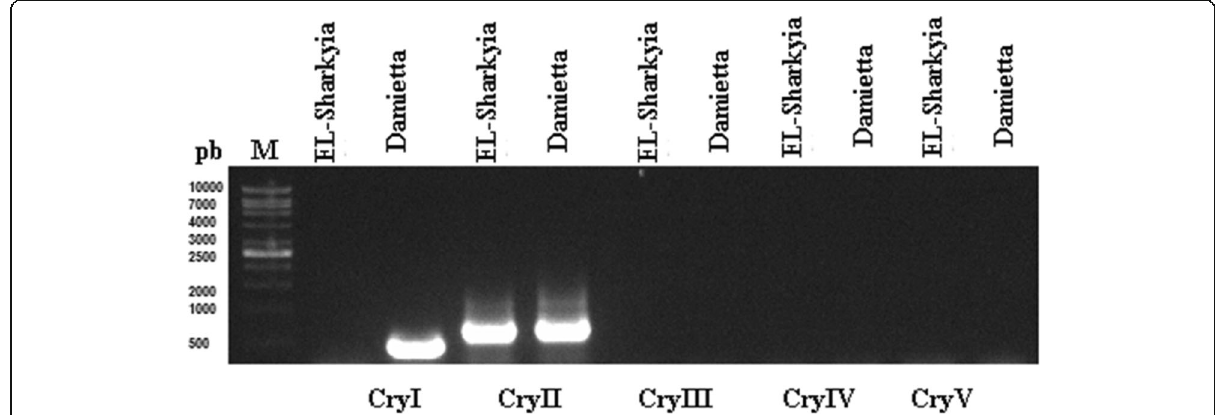
Fig. 4 Screening of selected Bacillus thuringiensis isolates using Cry I, Cry II, Cry III, Cry IV, Cry V specific oligonucleotide primers. M, represents page roller